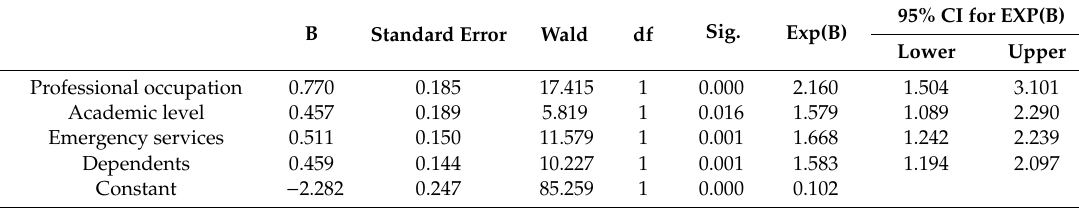
Table 3. Binary logistic regression